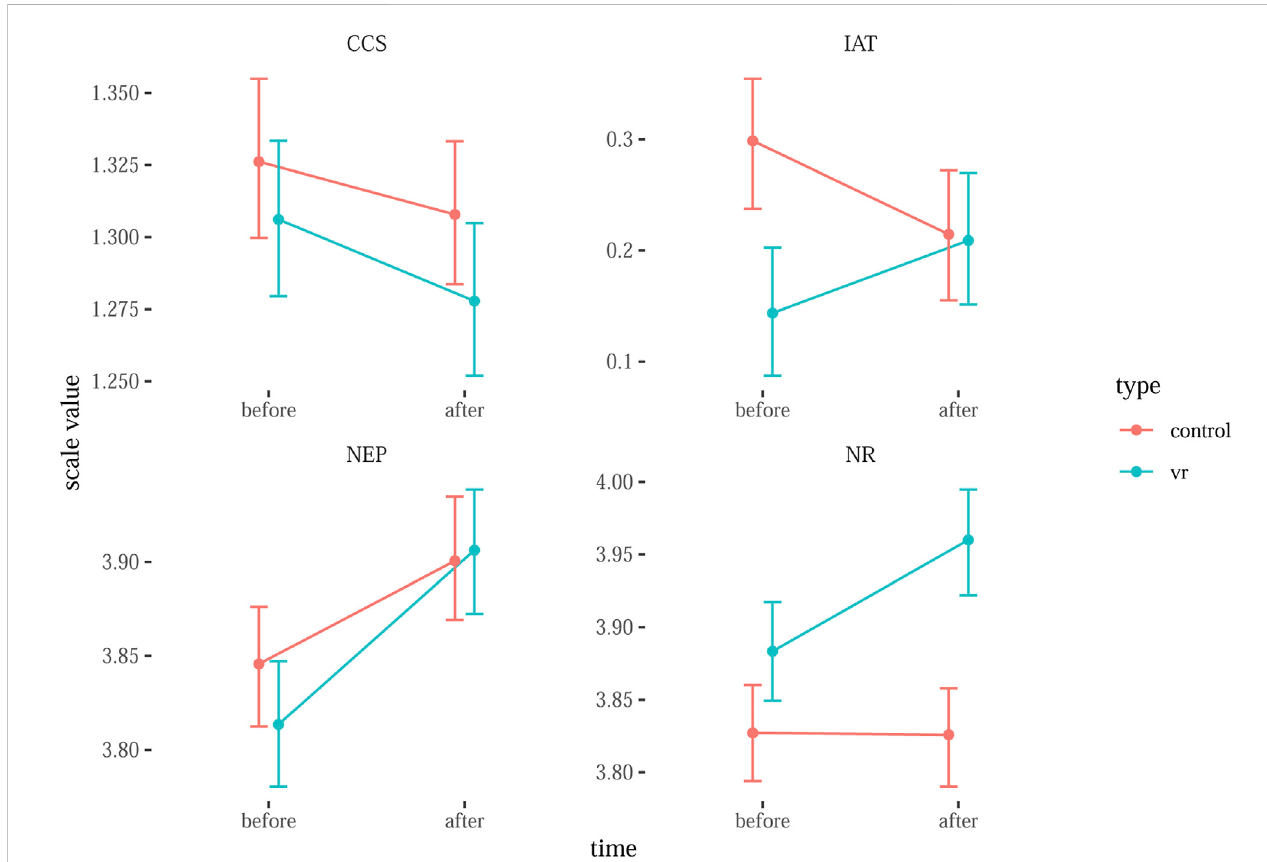
FIGURE 3 Conditional mean and CI of all four DV ’ s for VR vs. control conditions. CCS has been transformed back to its original scale.